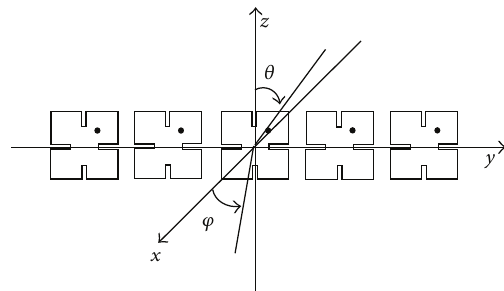
Figure 5: Structure of the circularly polarized microstrip array and the coordinate system.